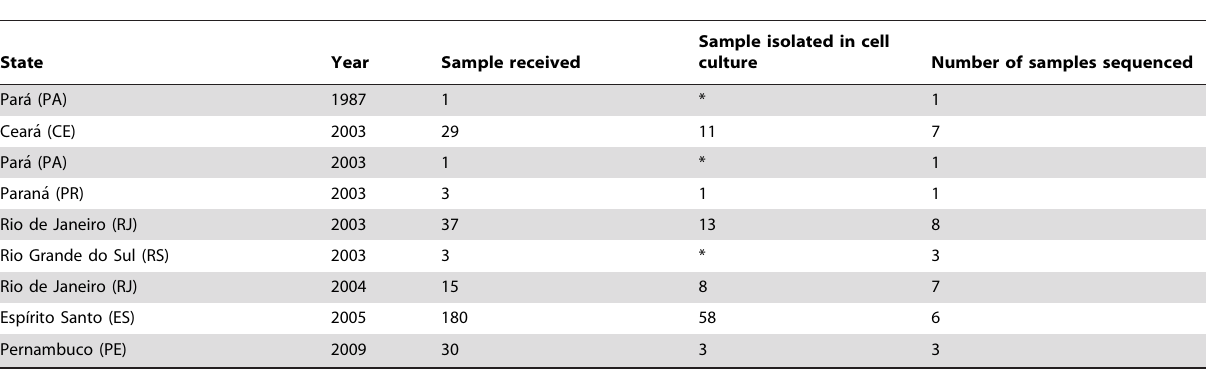
Table 1. Origin and number of CA24v isolates from Brazilian AHC outbreaks that were used for phylogenetic study.